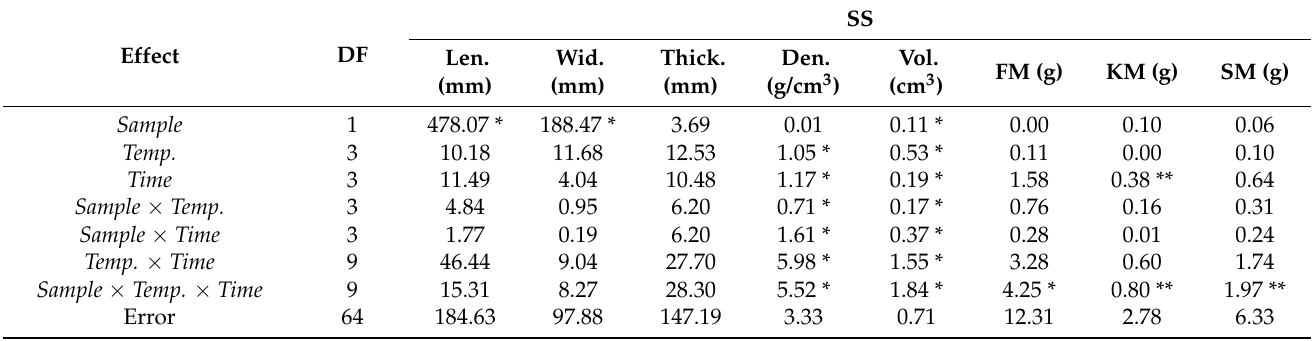
Table 6. Univariate analysis of changes in physical properties of hazelnuts as a function of sample parameters, drying time, and